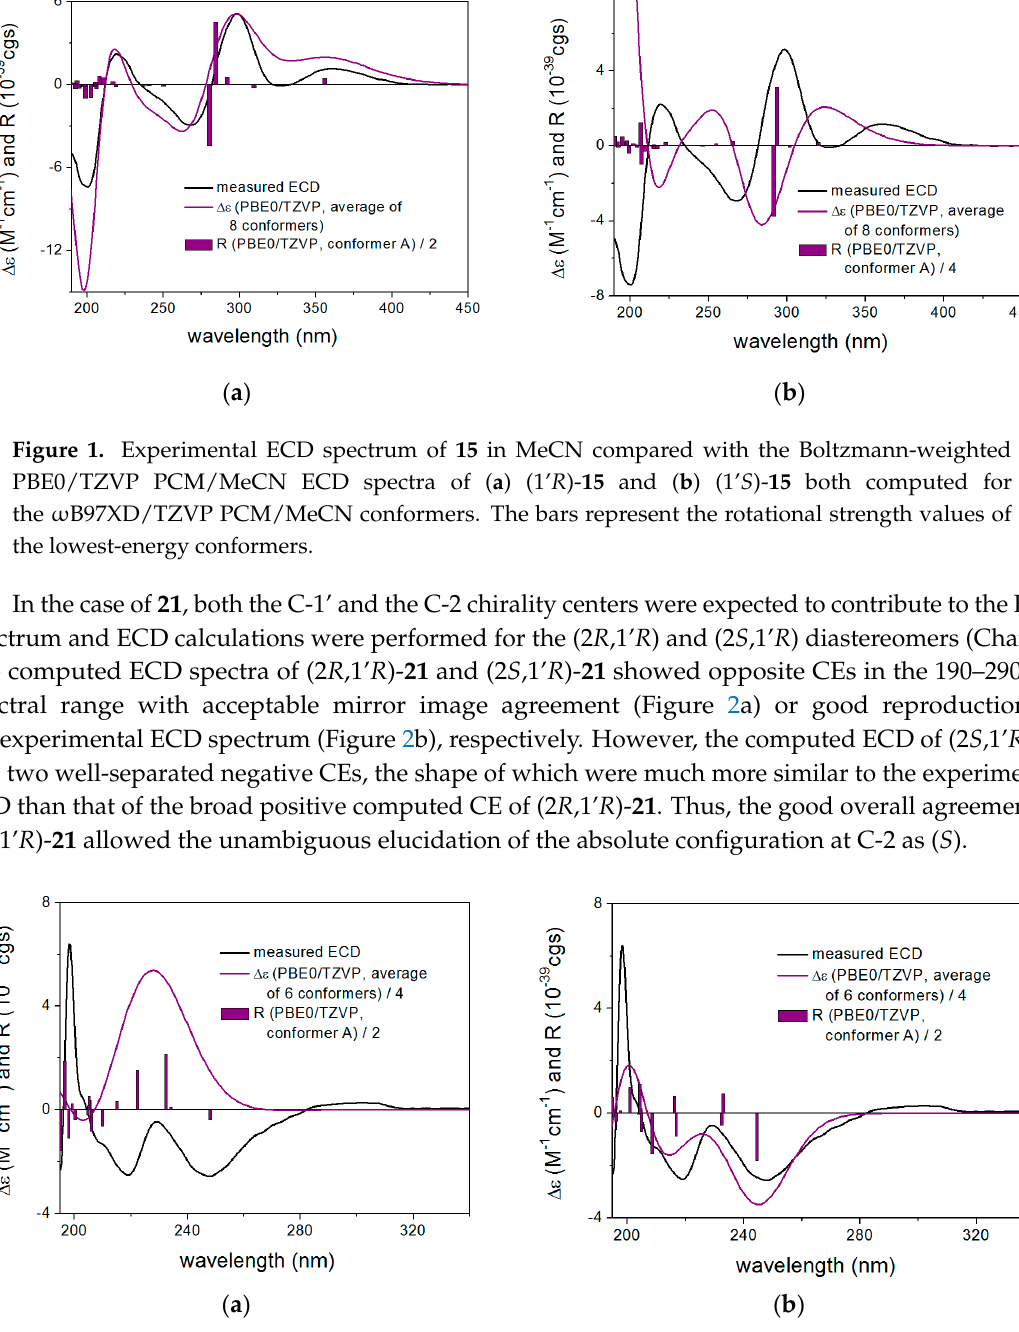
Figure 2. Experimental ECD spectrum of 21 in MeCN compared with the Boltzmann-weighted PBE0/TZVP PCM/MeCN ECD spectra of ( a ) (2 R ,1’ R )- 21 and ( b ) (2 S ,1’ R )- 21 both computed for the ω B97XD/TZVP PCM/MeCN conformers. The bars represent the rotational strength values of the lowest-energy conformers.